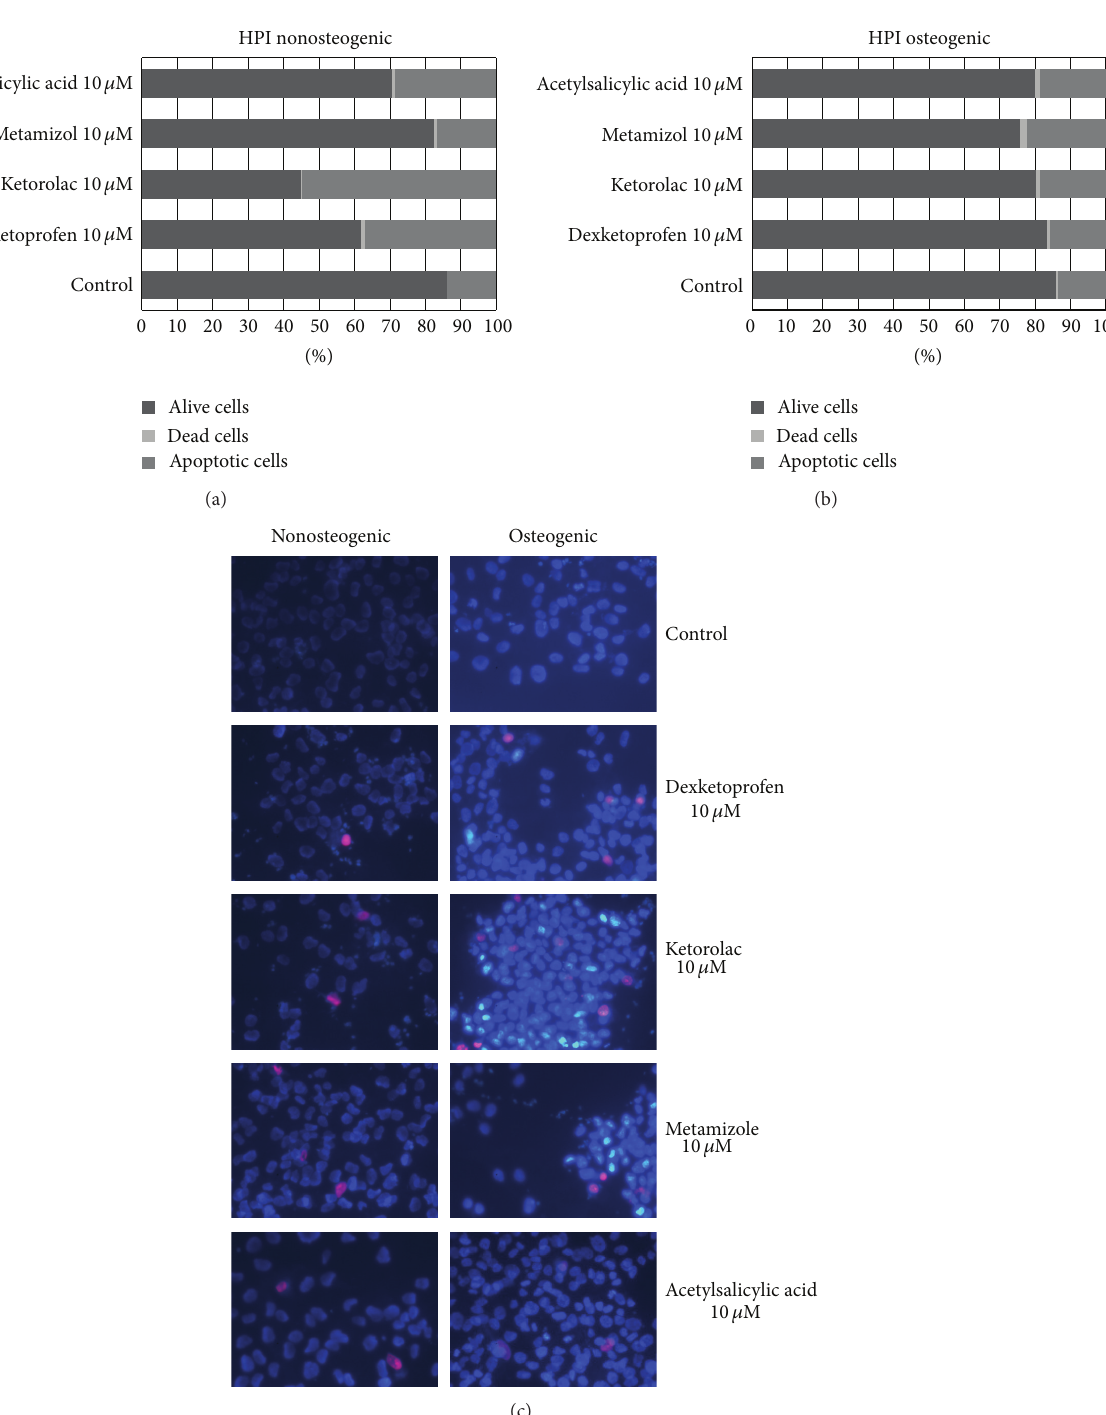
Figure 6: HPI: Effect of dexketoprofen, ketorolac, metamizole, and acetylsalicylic acid on cellular viability, cultured in nonosteogenic (a) and osteogenic mediums (b), after 24h of treatment at a dose of 10 𝜇 M. These micrographs are an example of MG63 treated with NSAIDs in nonosteogenic and osteogenic mediums